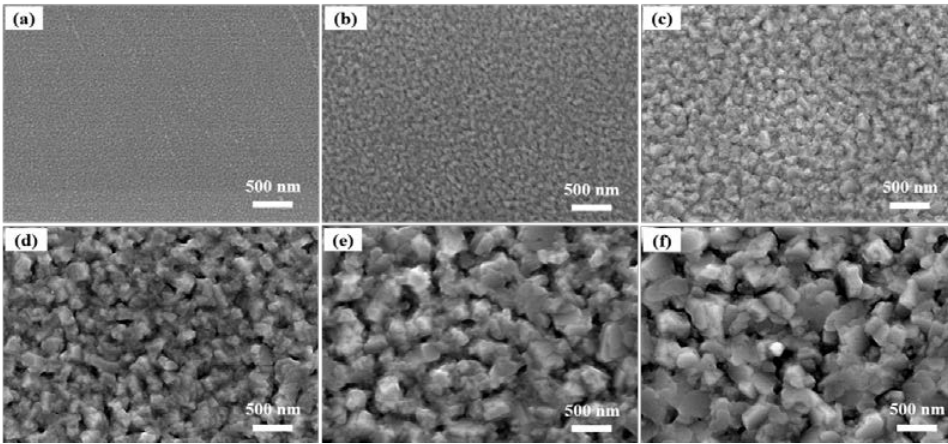
Figure 6. SEM images of the ITO/AgIn/ITO films at different sputtering temperatures. ( a ) 25 °C, ( b ) 100 °C, ( c ) 150 °C, ( d ) 200 °C, ( e ) 250 °C and ( f ) 300 °C, respectively.